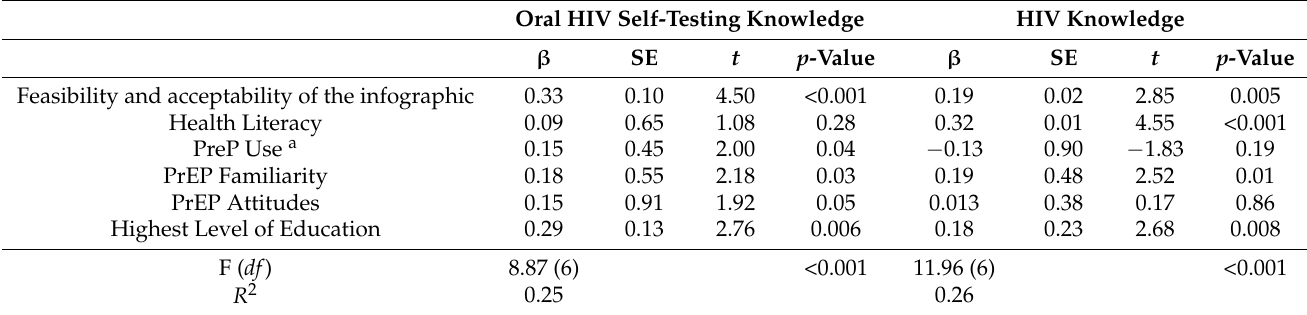
Table 6. Linear regression on oral HIV self-testing knowledge percent accuracy and HIV knowledge percent accuracy among experimental group ( n =